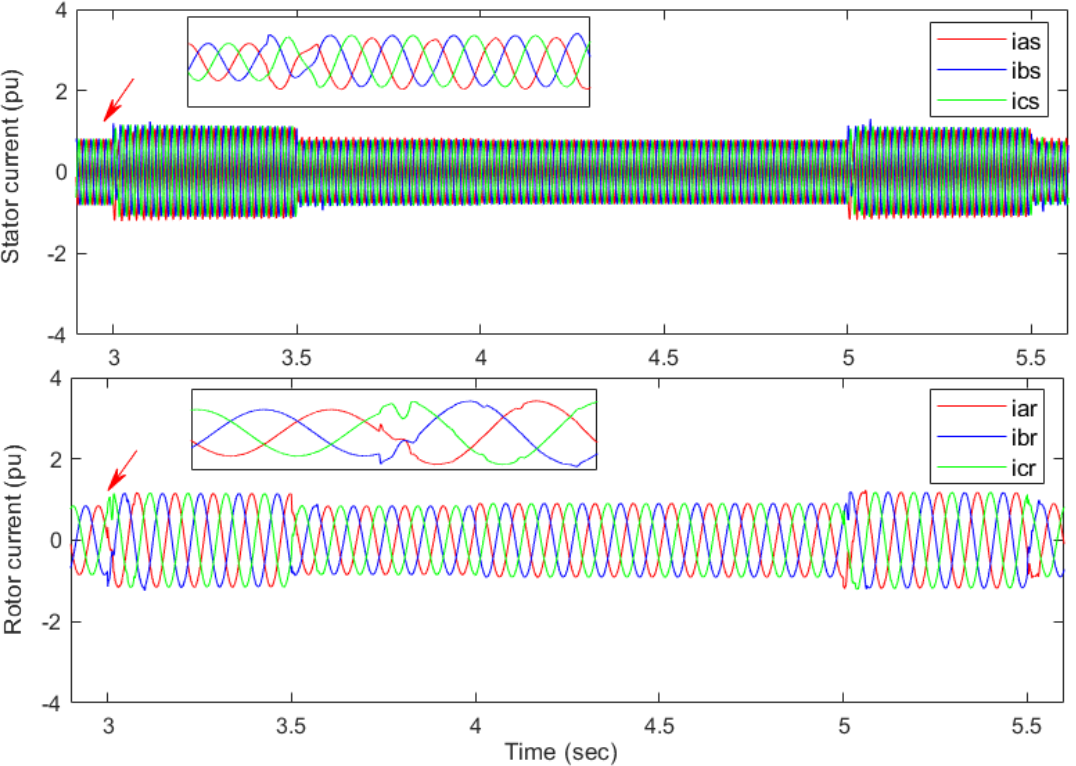
Figure 16. Simulation results of the stator and rotor currents under unbalanced grid voltage conditions and the influence of SPV (STA-SOSM controller case).